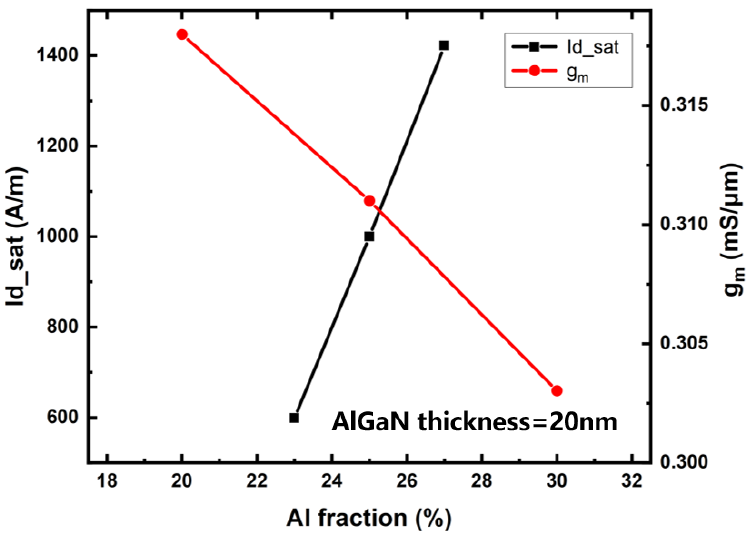
Figure 7. Simulation results of Al component on device saturation and transconductance.